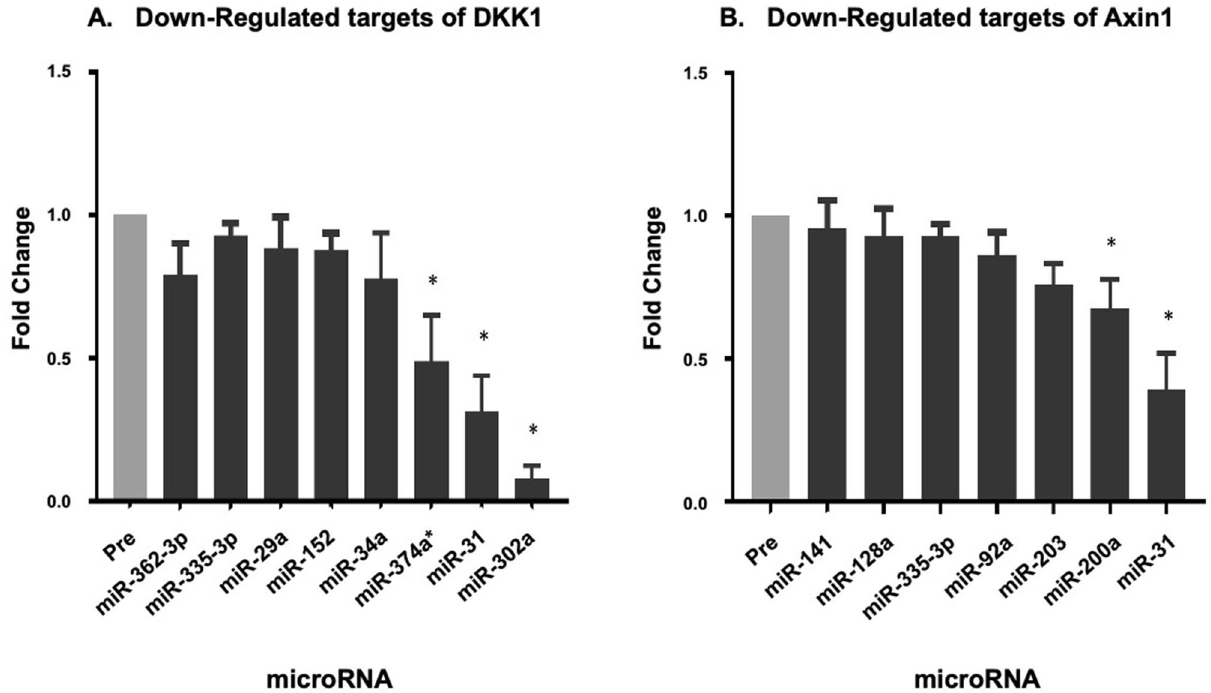
Figure 7. Potential miRNA targeting genes involved in the Wnt signalling pathway. All data are expressed mean ± SEM, n = 8 biological replicates. ( A ) Downregulated miRNA which potentially target DKK1; ( B ) Downregulated miRNA which potentially target Axin1. The differentially expressed miRNA are shown with an asterisk above them, while other potential targets do not have an asterisk.